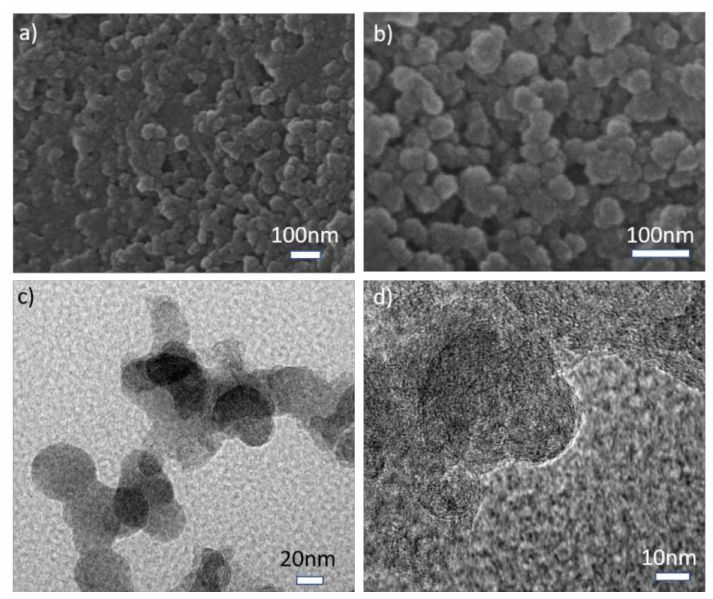
Figure 2. The micrographs of CNOs ( a , b ) are SEM images; ( c , d ) are HRTEM images.